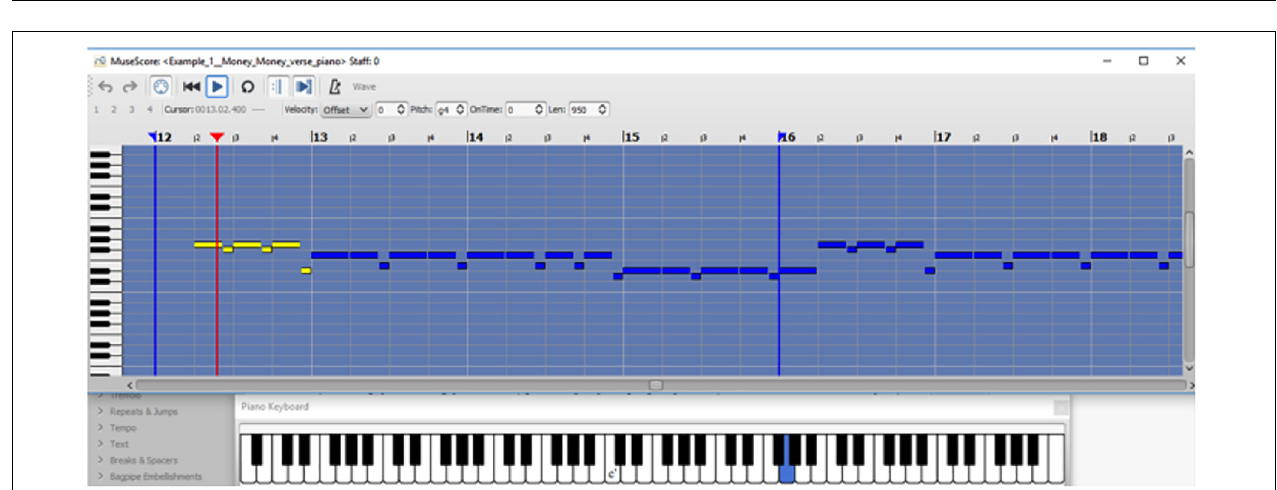
FIGURE 9 | Piano-roll view of the refrain